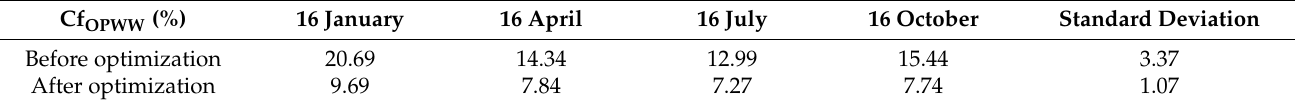
Table 4. Combined capacity factor before and after seasonal